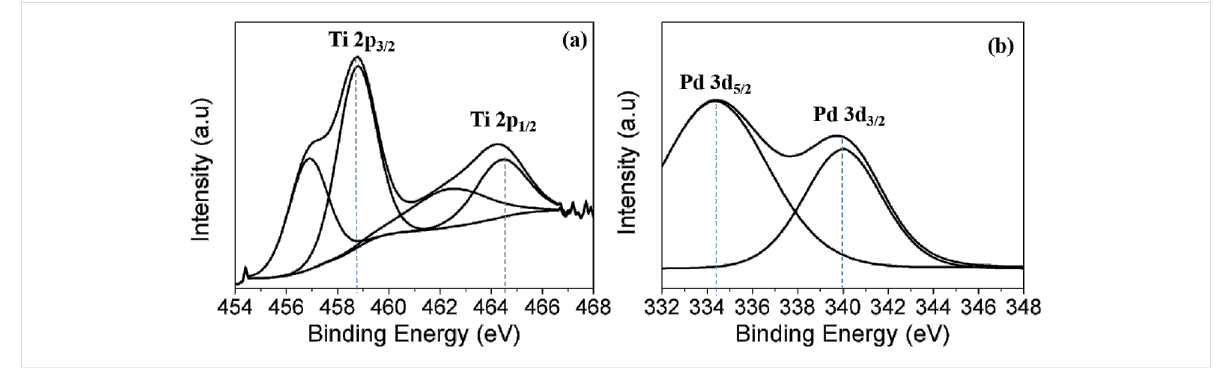
Figure 6: Core level XPS spectra of a) Ti 2p and b) Pd 3d of 0.5 wt % Pd/TiO 2 .